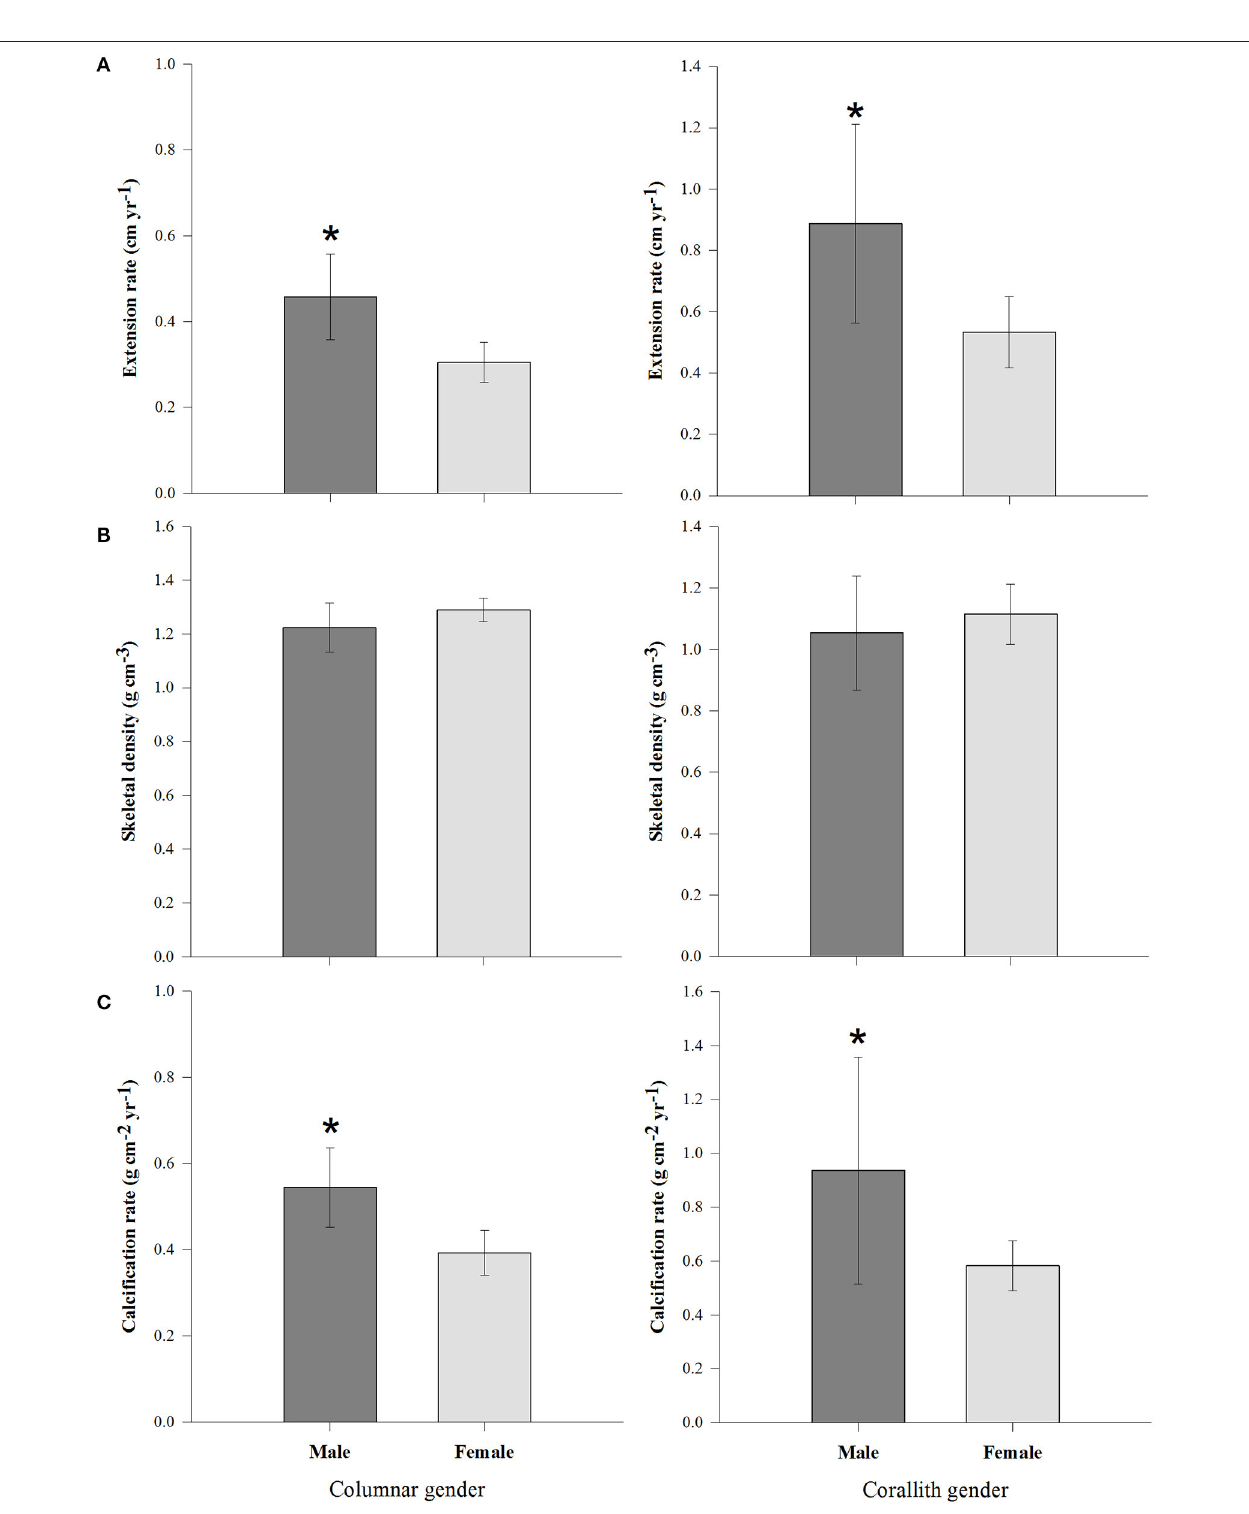
FIGURE 4 | Growth parameters ( ± 95% confidence limits) of columnar and corallith morphotypes including the gender effect (differences between males and females). (A) Extension between males and females. (B) Skeletal density between male and females. (C) Calcification rate between male and females. *denotes statistically significant difference ( P <